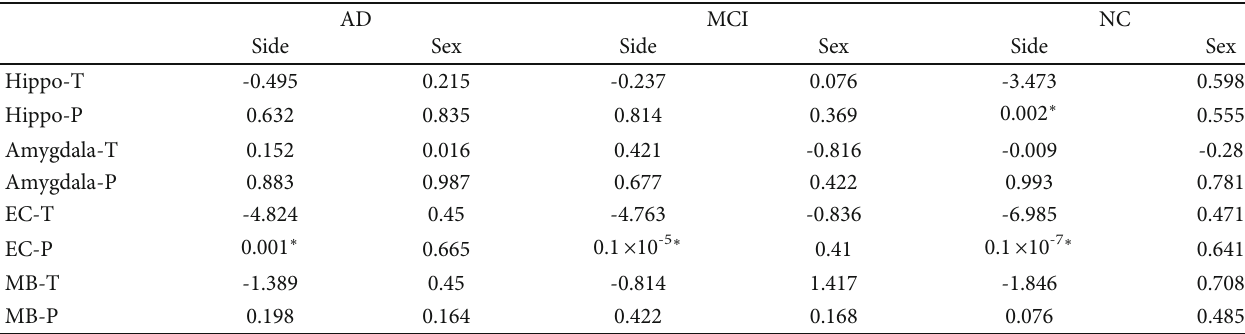
Table 2: Statistical analytical results of side di ff erences and sex di ff erences in the subjects ’ GM densities of bilateral ROIs inside each group. Side di ff erences: the densities of the right side of the entorhinal cortex inside each group and the hippocampus from the NC group were higher than those of the left side, this di ff erence was statistically signi fi cant ( p < 0 : 05 ), and densities of the amygdala and mammillary body were bilaterally symmetric. Sex di ff erences: four ROIs in each group did not show any sex di ff erences ( p > 0 : 05